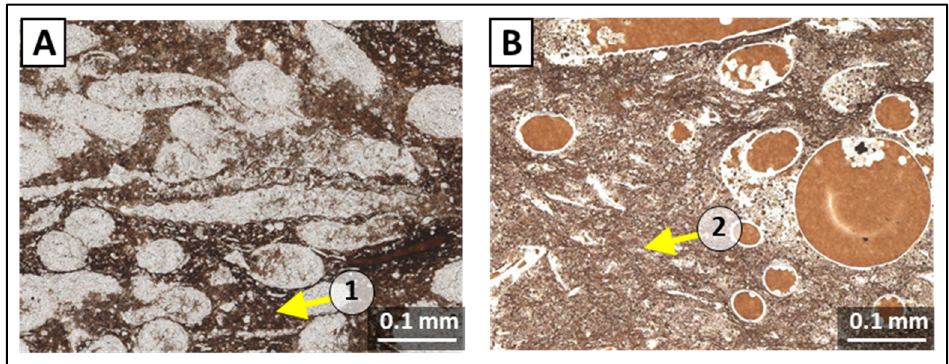
Figure 9. Thin section images of D5 ( A ) and D6 ( B ) lithotypes. Dark brown is an organic matter, (1) and (2) light mineral inclusions within organic matter.